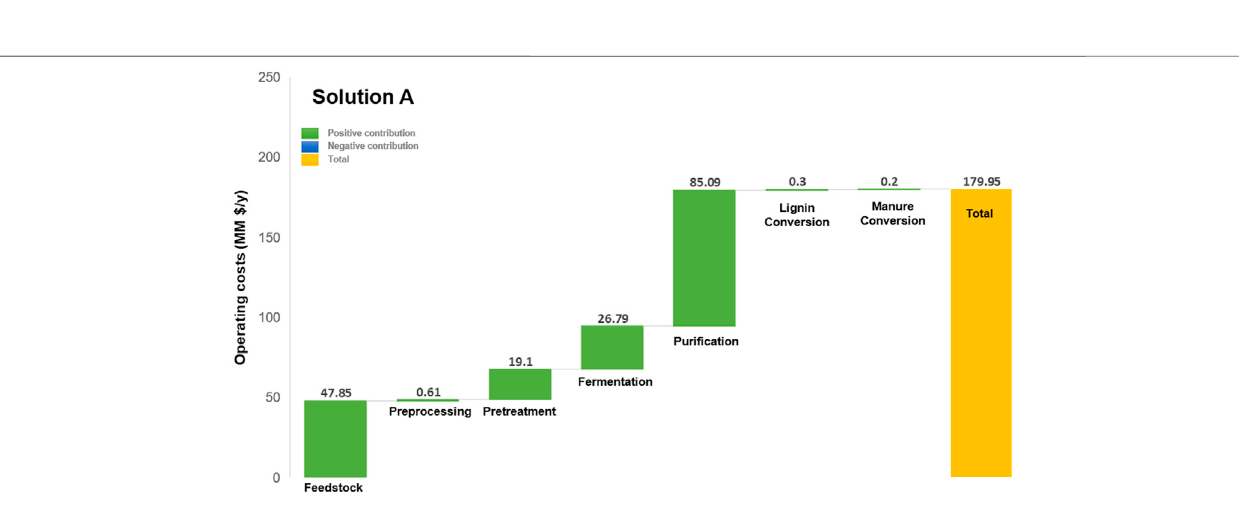
Frontiers in Chemical Engineering |